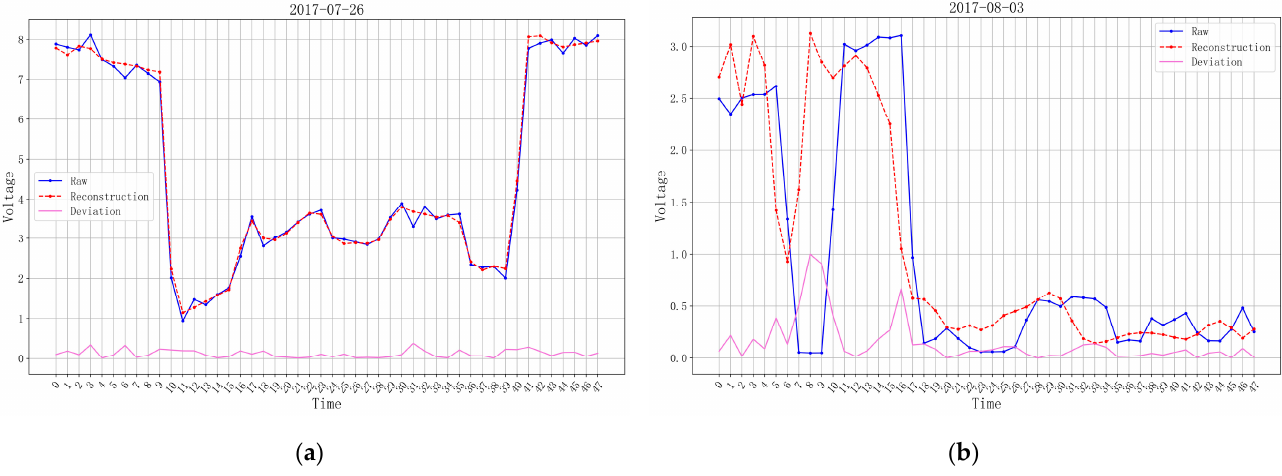
Figure 9. A detailed fitted curve for one day. ( a ) The fitting curve without anomalies; ( b ) the fitting curve with anomalies. Table 2. Station abnormal points before the Jiuzhaigou